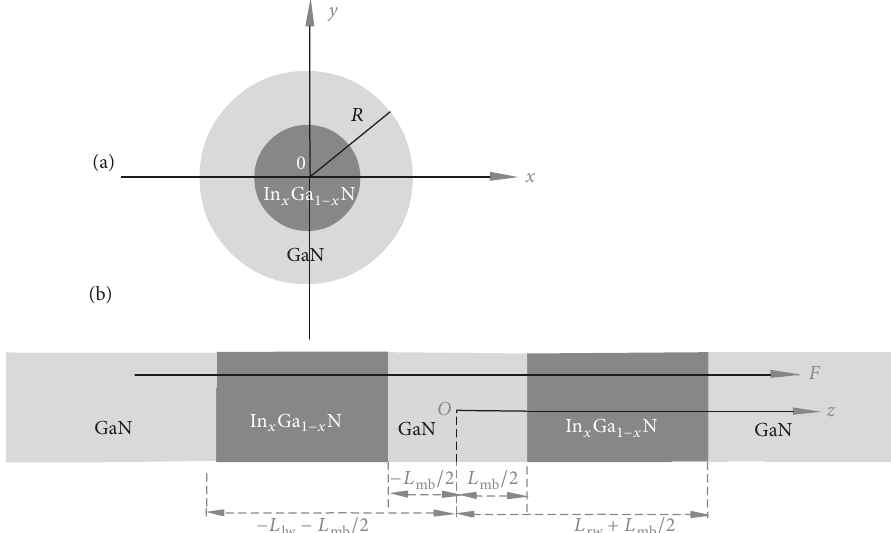
Figure 1: A diagram of a cylindrical ZB In 𝑥 Ga 1−𝑥 N/GaN symmetric coupled QDs of the radius 𝑅 , the left dot height 𝐿 lw , the middle barrier width 𝐿 mb , and the right dot height 𝐿 rw . The 𝑧 -axis is defined to be the growth direction of the SCQDs, and the external electric field is applied along 𝑧 -axis of the coupled